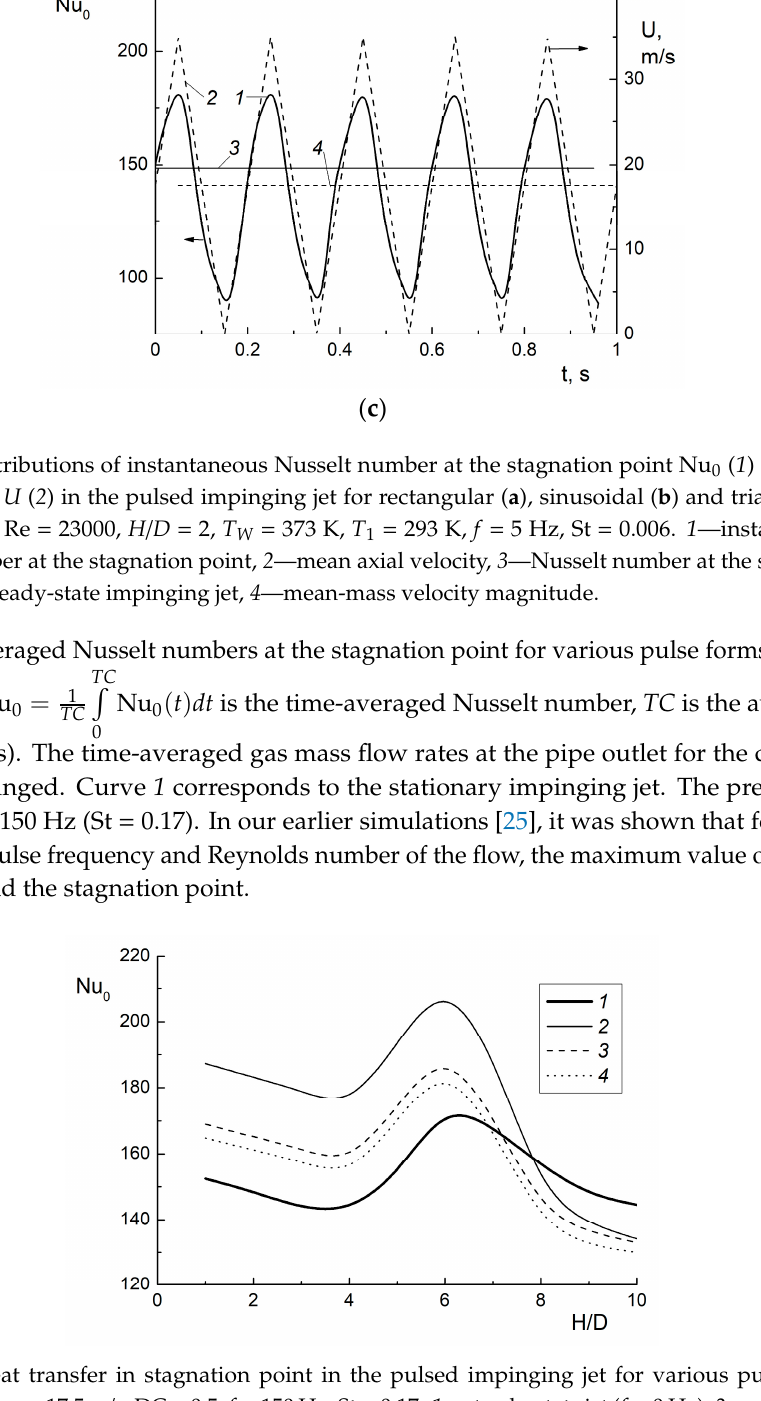
Figure 6. Heat transfer in stagnation point in the pulsed impinging jet for various pulse forms. Re = 23000, U m 1 = 17.5 m/s, DC = 0.5, f = 150 Hz, St = 0.17. 1 —steady-state jet ( f = 0 Hz); 2 —rectangular; 3 —sinusoidal, 4 —triangular.